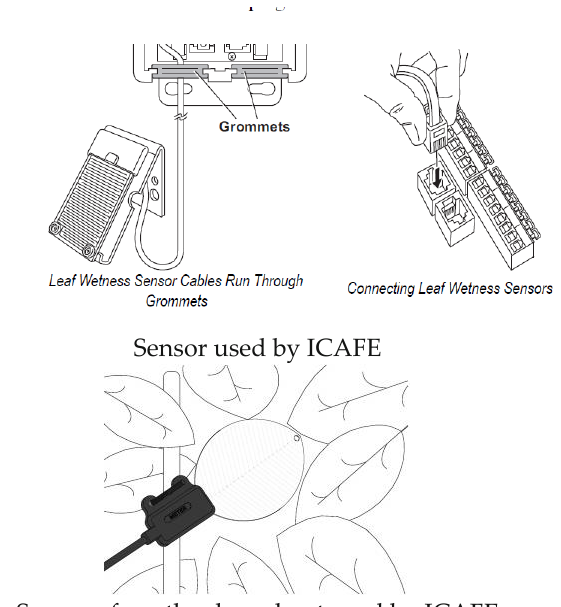
Figure 1. Sensor used by ICAFE and sensor from another brand. Note: Images taken from [8,9].